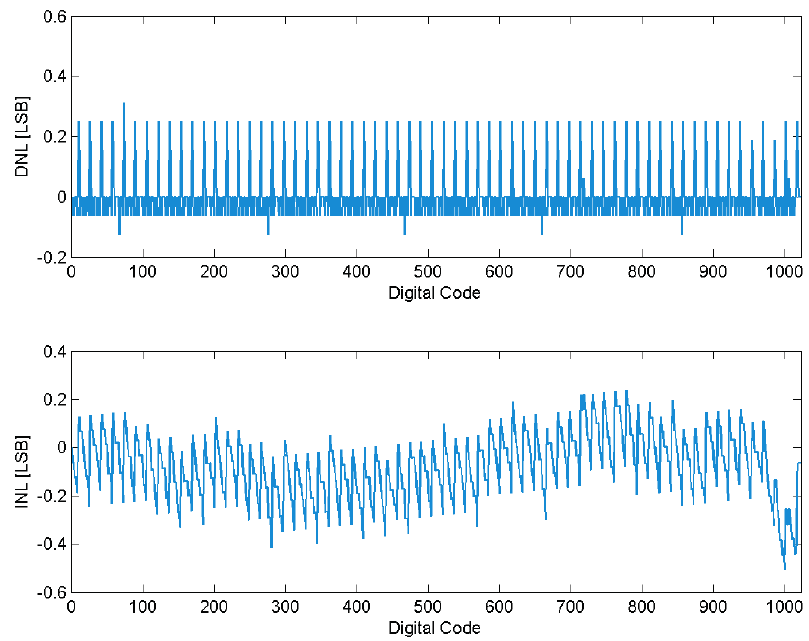
Figure 16. DNL and INL with calibration.